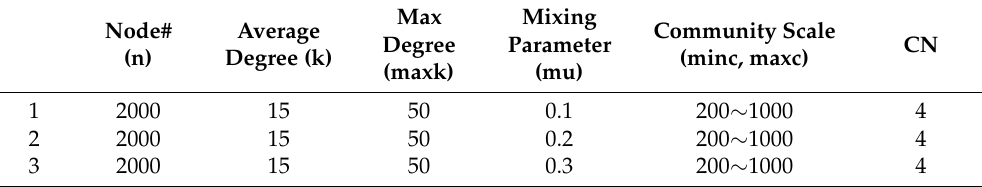
Table 7. Parameters of the datasets generated by LFR benchmark.